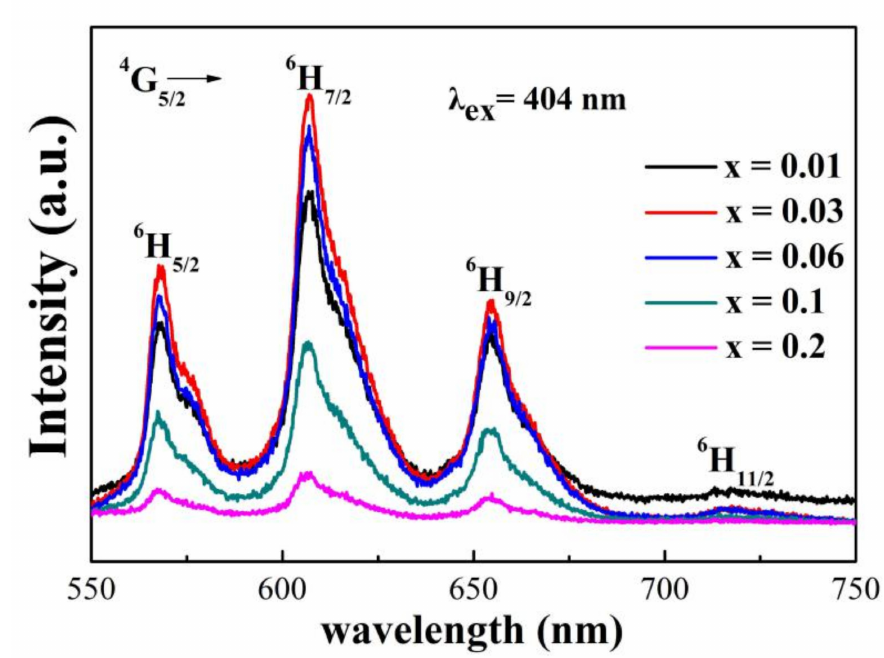
Figure 7. Photoluminescence emission spectra of Al 2 O 3 -(3-x)SrO: xSm 3+ (x = 0.01, 0.03, 0.06, 0.1, 0.2) glasses ( λ ex = 404